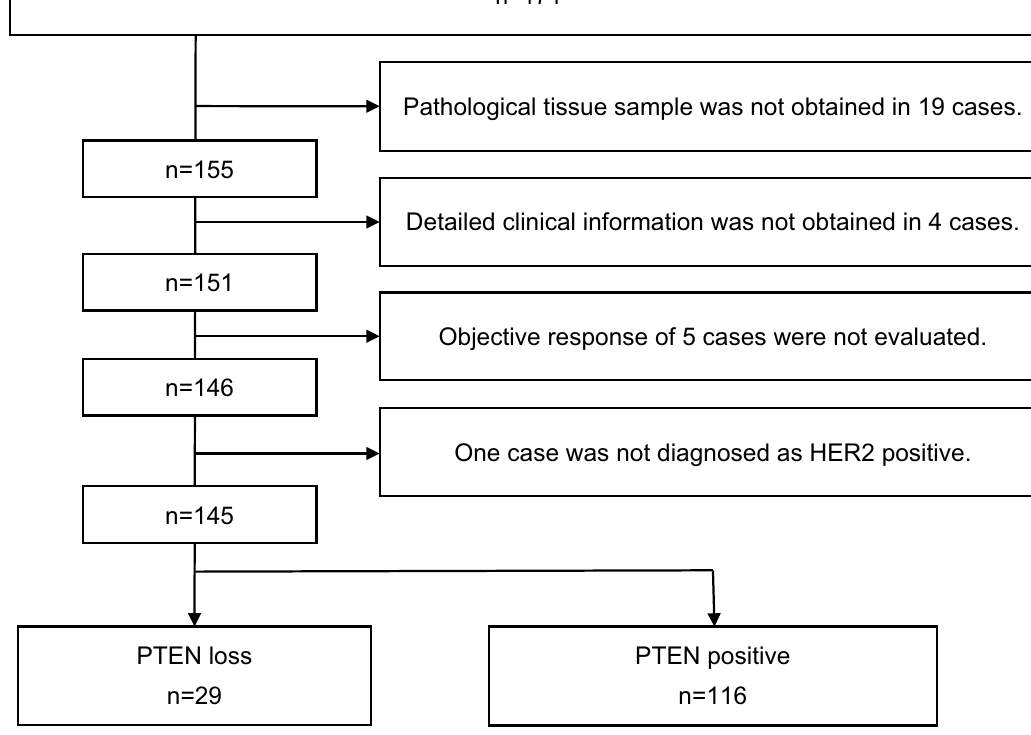
Table 1. Flow diagram of study selection. One hundred forty-five patients were assigned to either the PTEN- loss or PTEN-positive group, based on the PTEN IHC results. The PTEN-loss group had 29 patients and the PTEN-positive group had 116